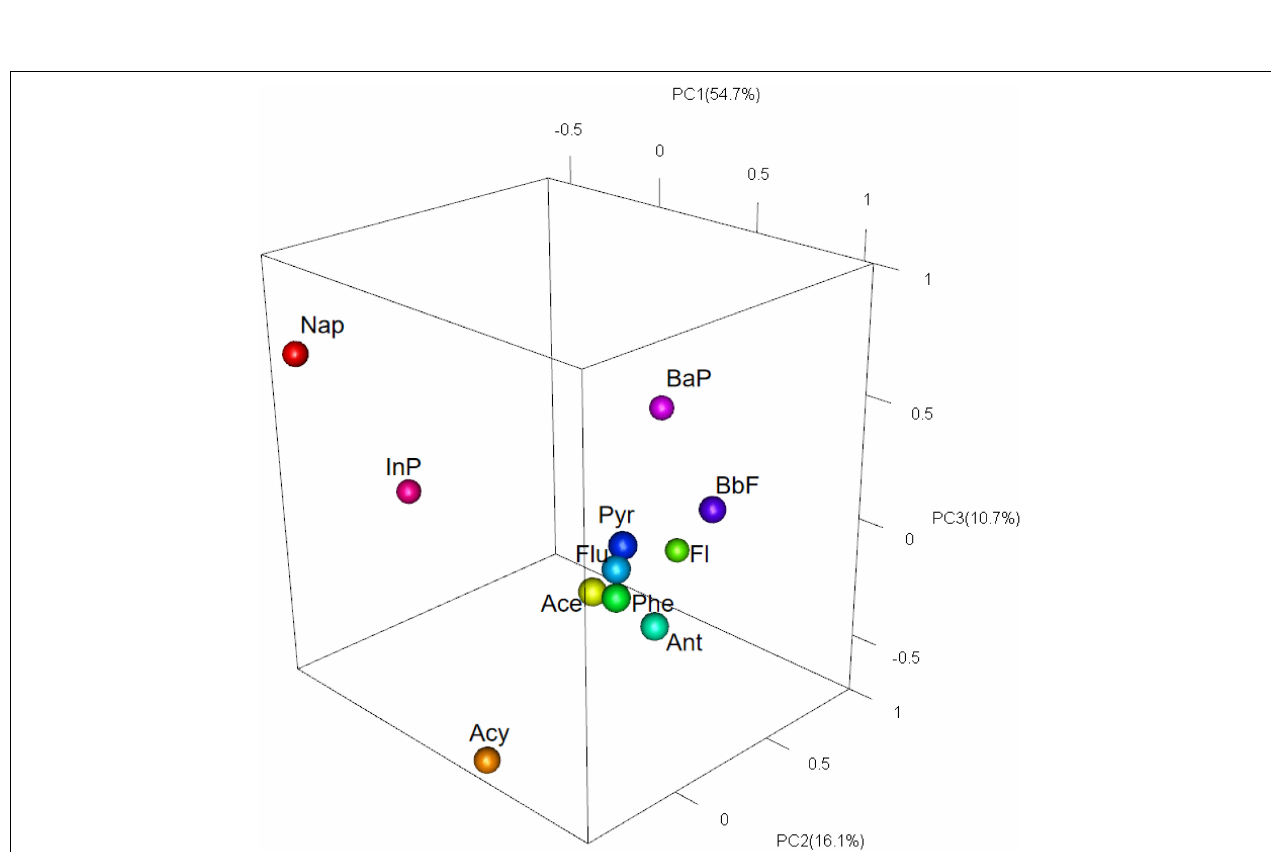
FIGURE 4 | Cross plot of the molecular diagnostic ratios of Flu/(Flu + Pyr) and Ant/(Phe + Ant) in the marine organisms.